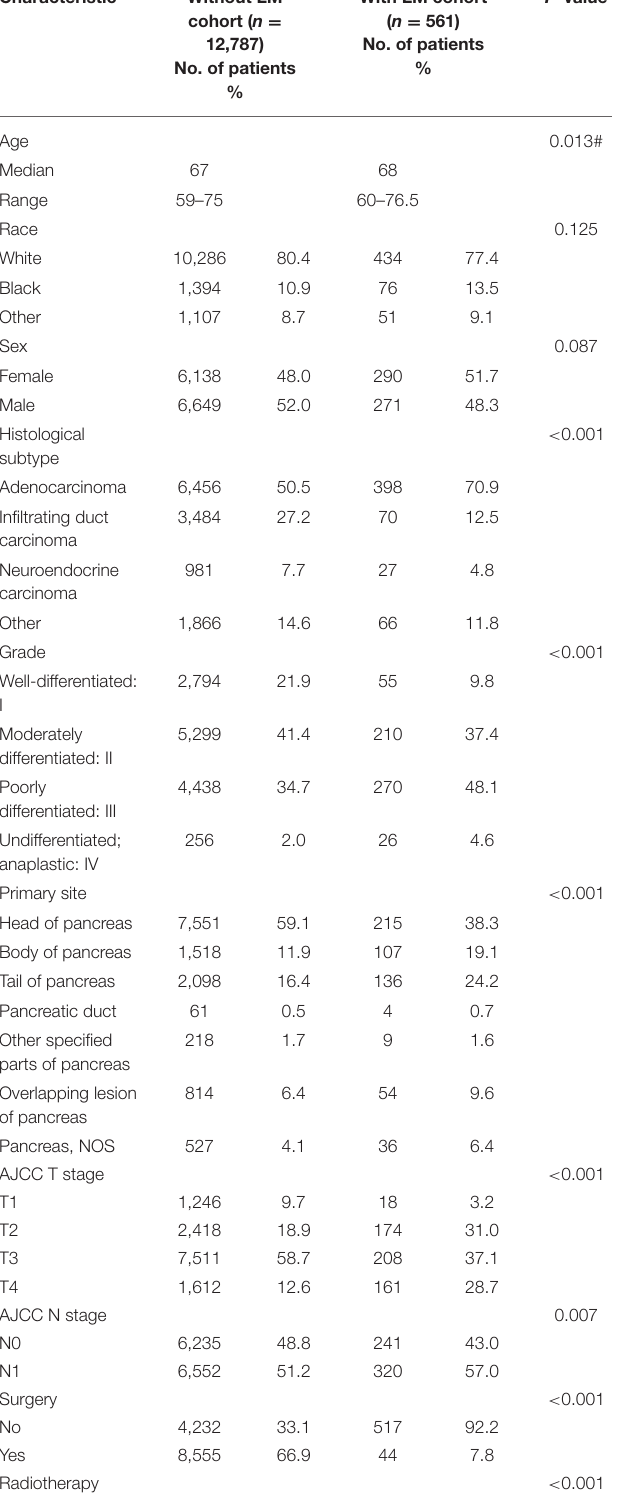
TABLE 2 | Demographic and clinicopathological characteristics of pancreatic cancer patients with lung metastases in training cohort.